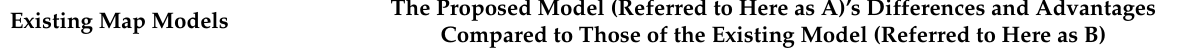
Table 1. Comparison of the proposed model with other map